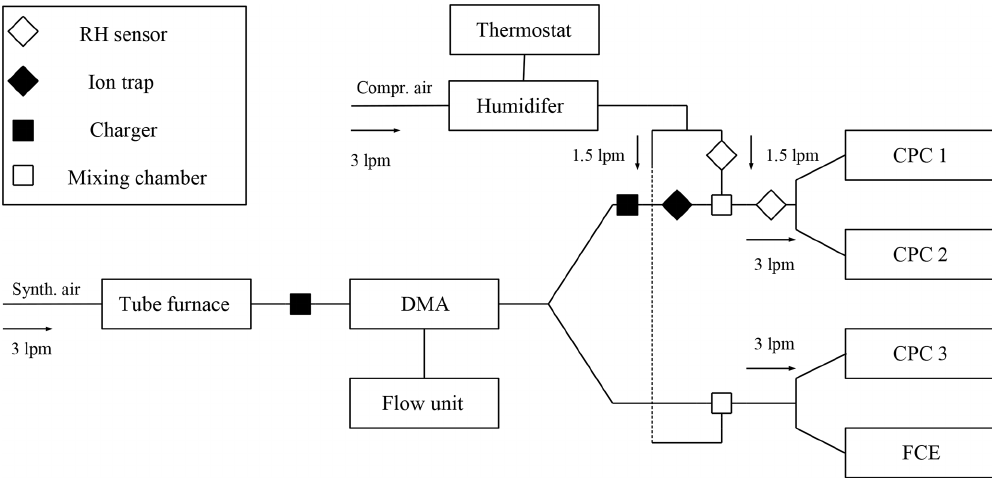
Figure 1. The experimental setup for evaluating the relative-humidity-dependent counting efficiency of continuous flow type CPCs (TSI 3776 UCPC), which was measured relative to a Faraday cup electrometer (FCE) (Wlasits, 2019).